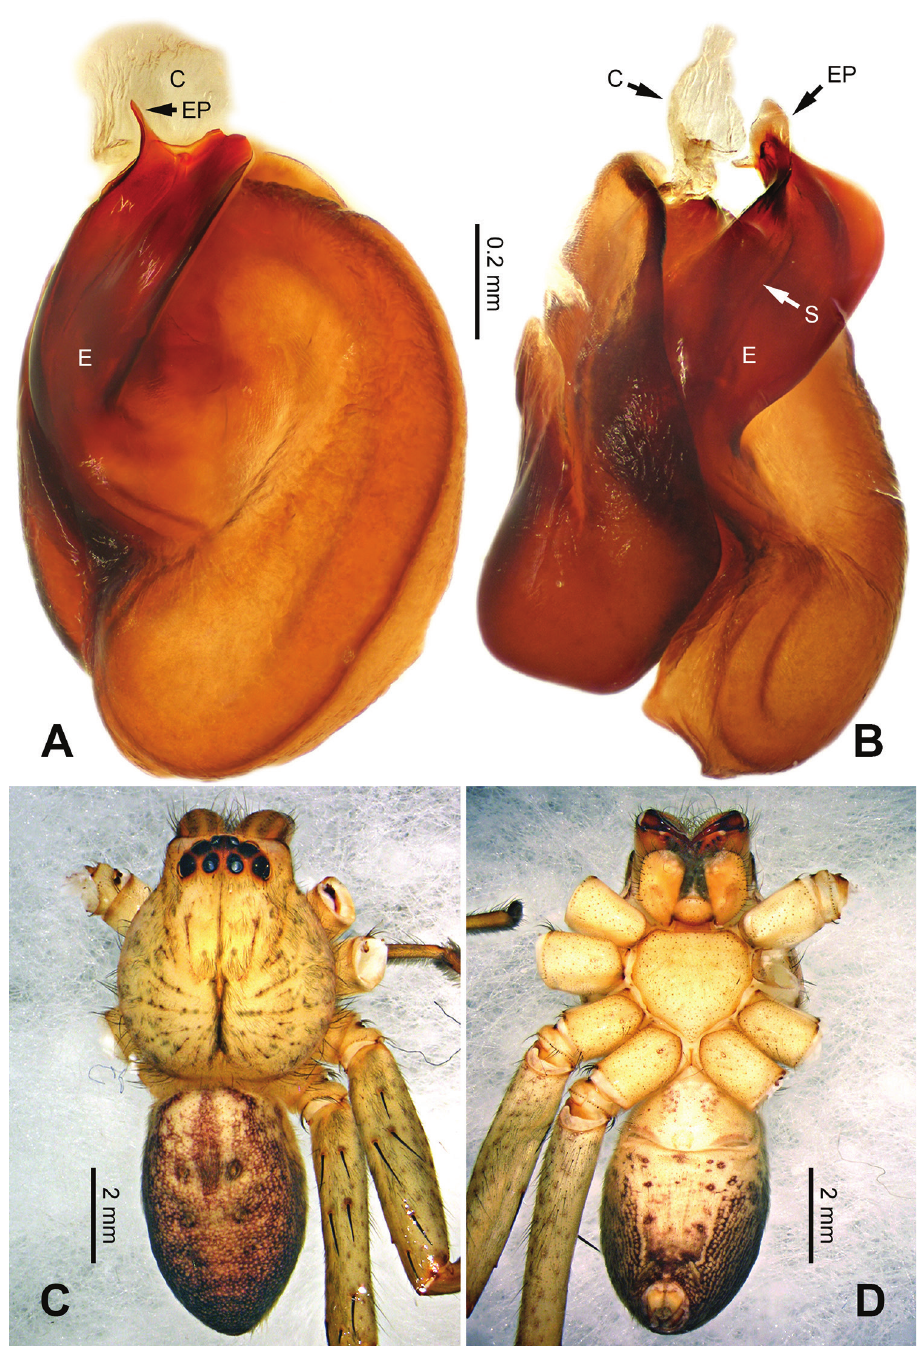
Figure 35. Pseudopoda zixiensis Zhao & Li, sp. n., male holotype. A Bulb, ventral view B Bulb, dorsal view C Habitus, dorsal view D Habitus, ventral view. Scale bar equal for A, B